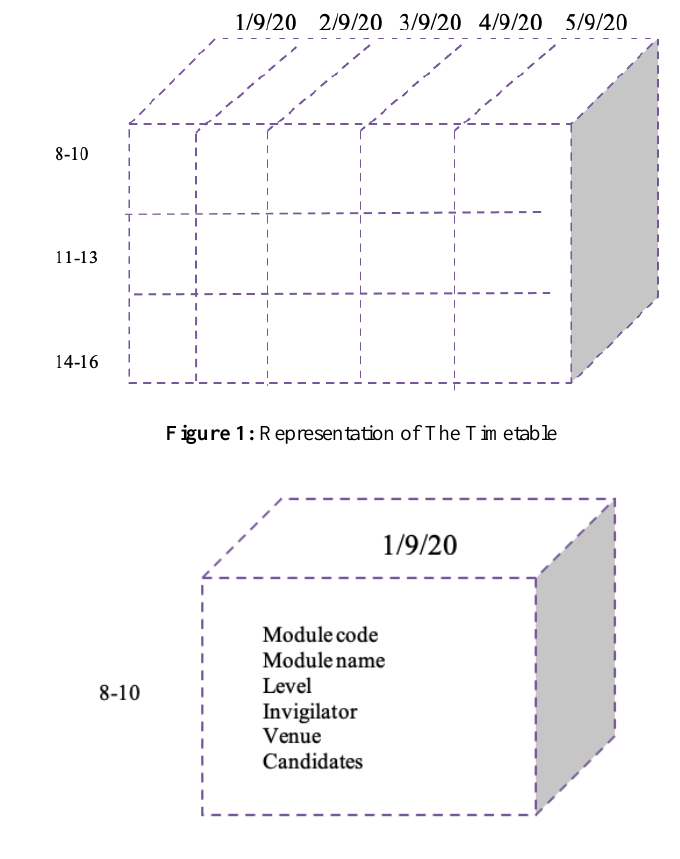
Figure 2: Representation of a Cell of The